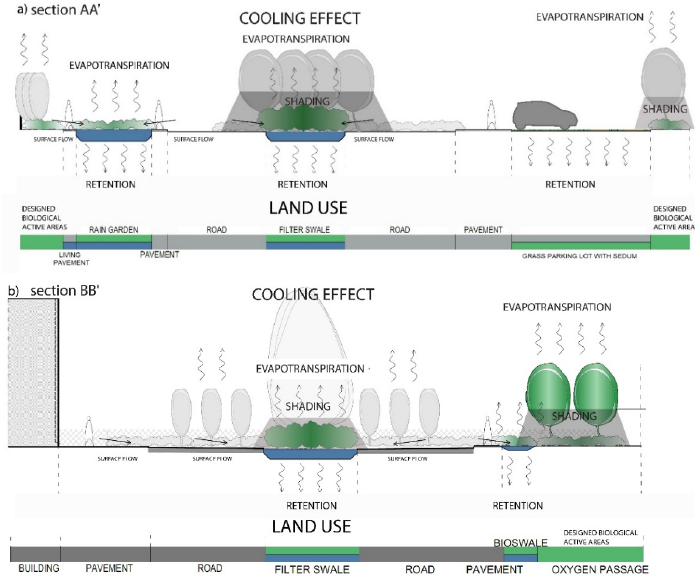
Figure 3. Introduction of hybrid infrastructure solutions: ( a ) section AA’ and ( b ) section BB’.